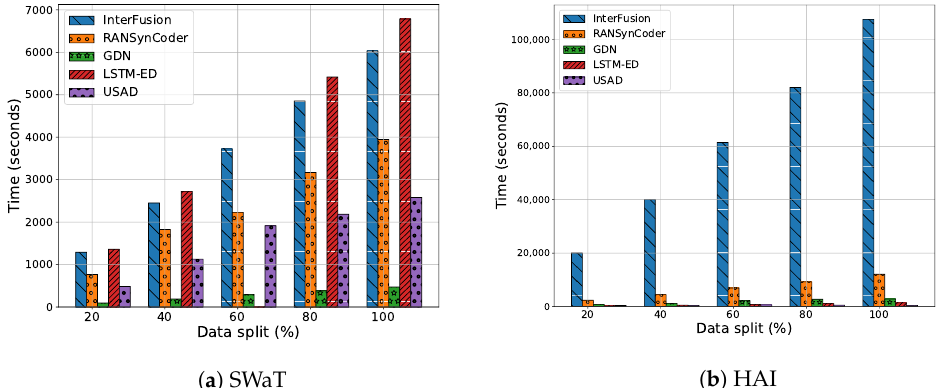
Figure 7. Changes in training times of the anomaly detection models with data split ratio.